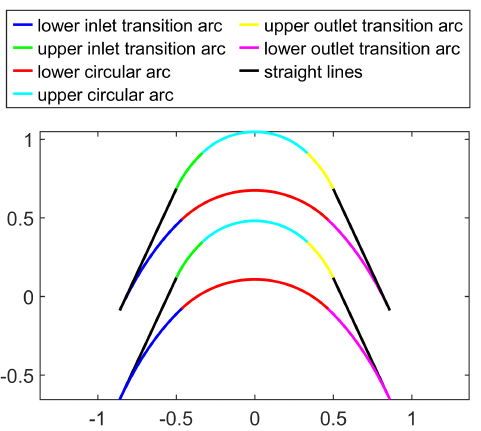
Figure 3. Blade profile sector division in vortex-flow